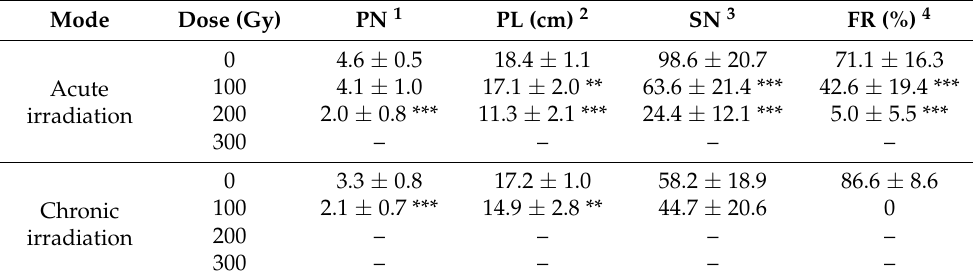
Table 1. Reproduction in rice plants subjected to acute and chronic gamma